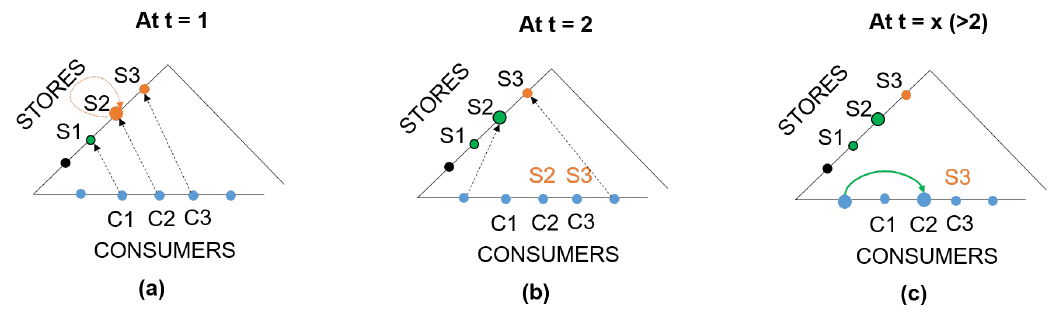
Figure 3. Conceptualization of the Proposed Model using Routine Activity Theory. ( a ) At t = 1, ( b ) At t = 2, ( c ) At t = x